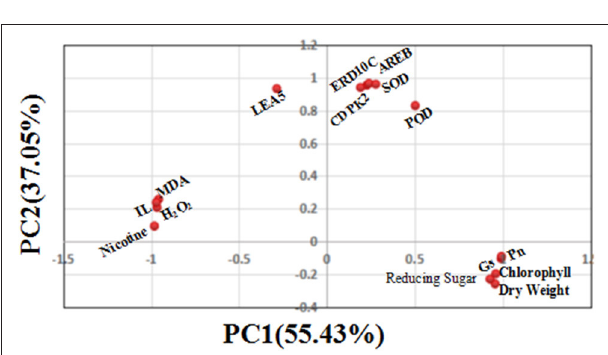
FIGURE 10 | Scatter plot of the top two principal components (including 15 physiological biochemical and gene transcript parameters) under drought stress. The proportion of variance for principal component analysis based on the drought stress index (DSI) of 15 physiological traits is shown in the figure, showing that PC1 and PC2 explain 92.48% of total